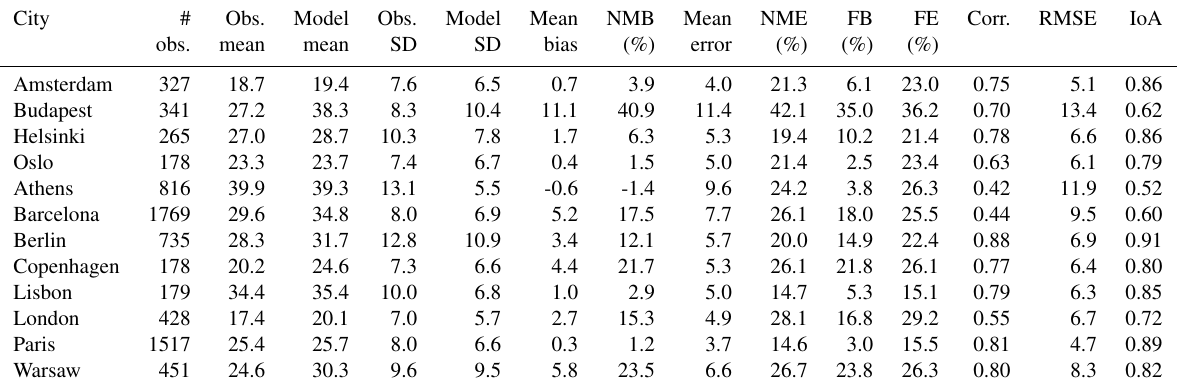
Table 3. Summary of CAMx model performance evaluated at background AirBase sites belonging to the selected cities. Statistics are computed for daily mean O 3 concentrations over the summer season (1 July–30 September).